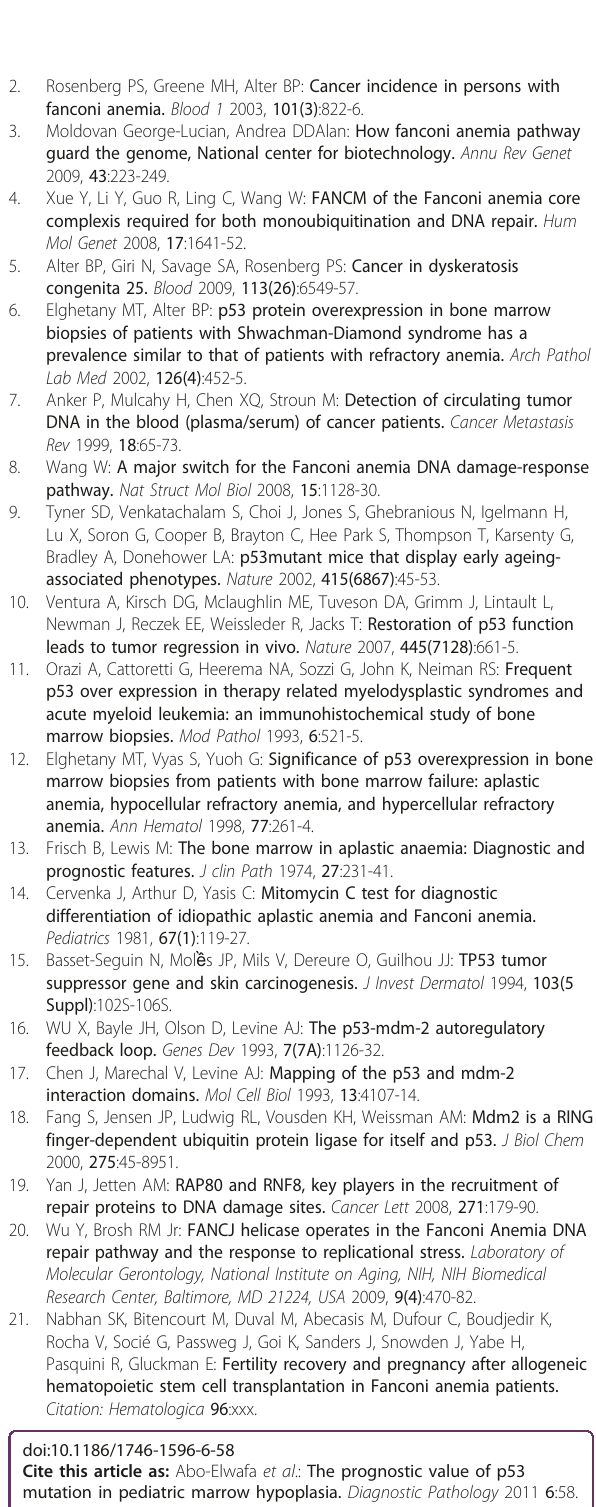
Table 4 p53 gene expression by real-time PCR